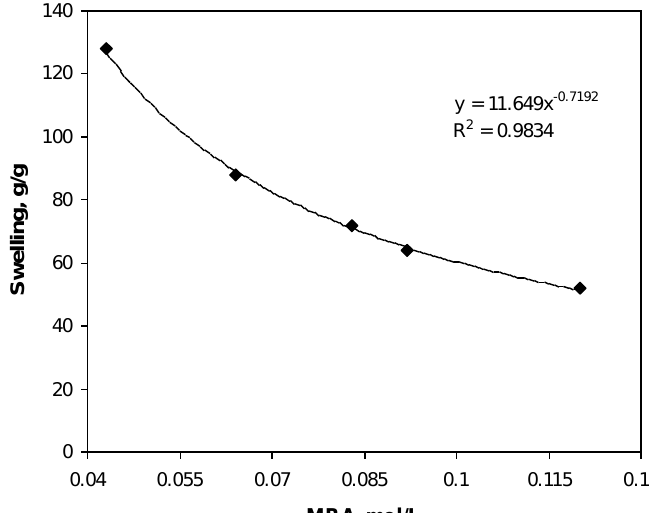
Figure 1. Effect of crosslinker concentration on swelling